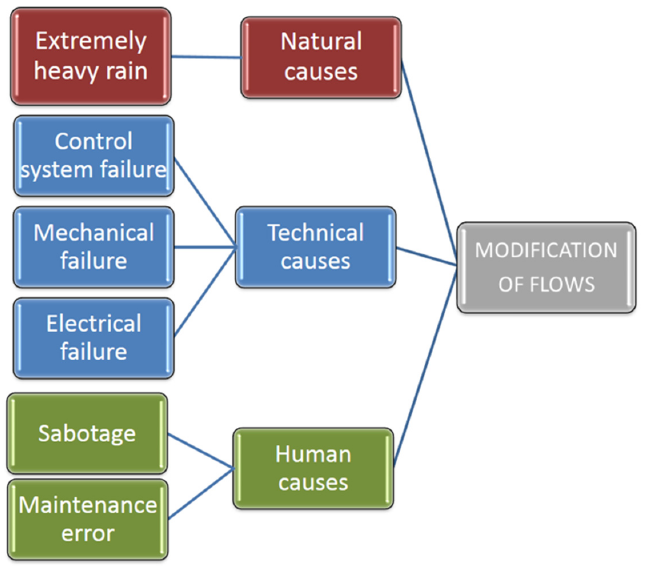
Figure 5. Tree formulation of the cause-and-effect analysis for the modification of flow effects.